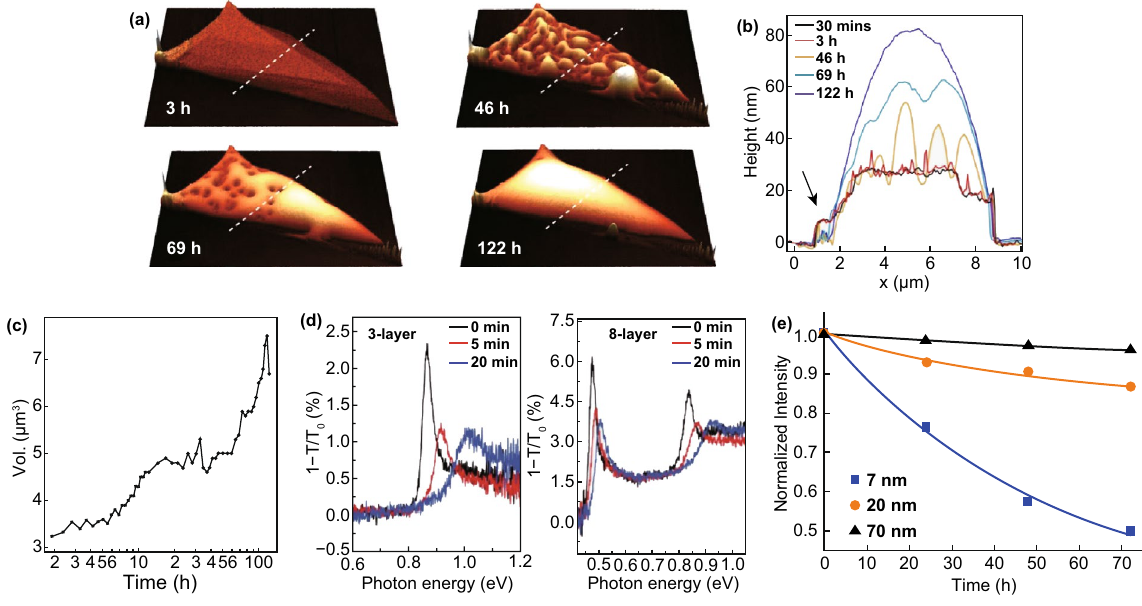
Fig. 5 a AFM image, b height change curves and c volume change curves of BP in different exposed times [47]. d The blueshift of 3-layer and 8-layer BP in IR spectra [96]. e The evolution of the intensity of Raman normalized peak A g1 of BP with exposed time [97]. Adapted from Refs. [47, 96, 97] with